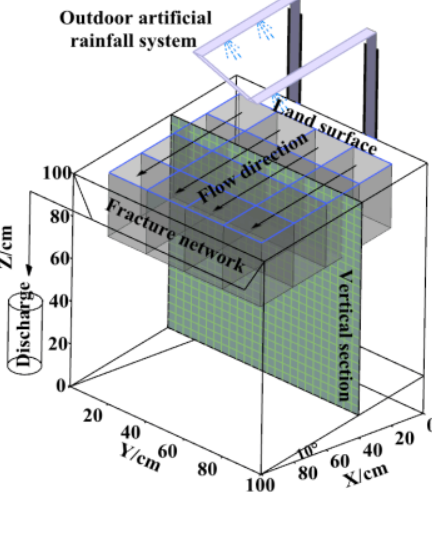
Figure 3. Diagram of S3 experimental set-up.